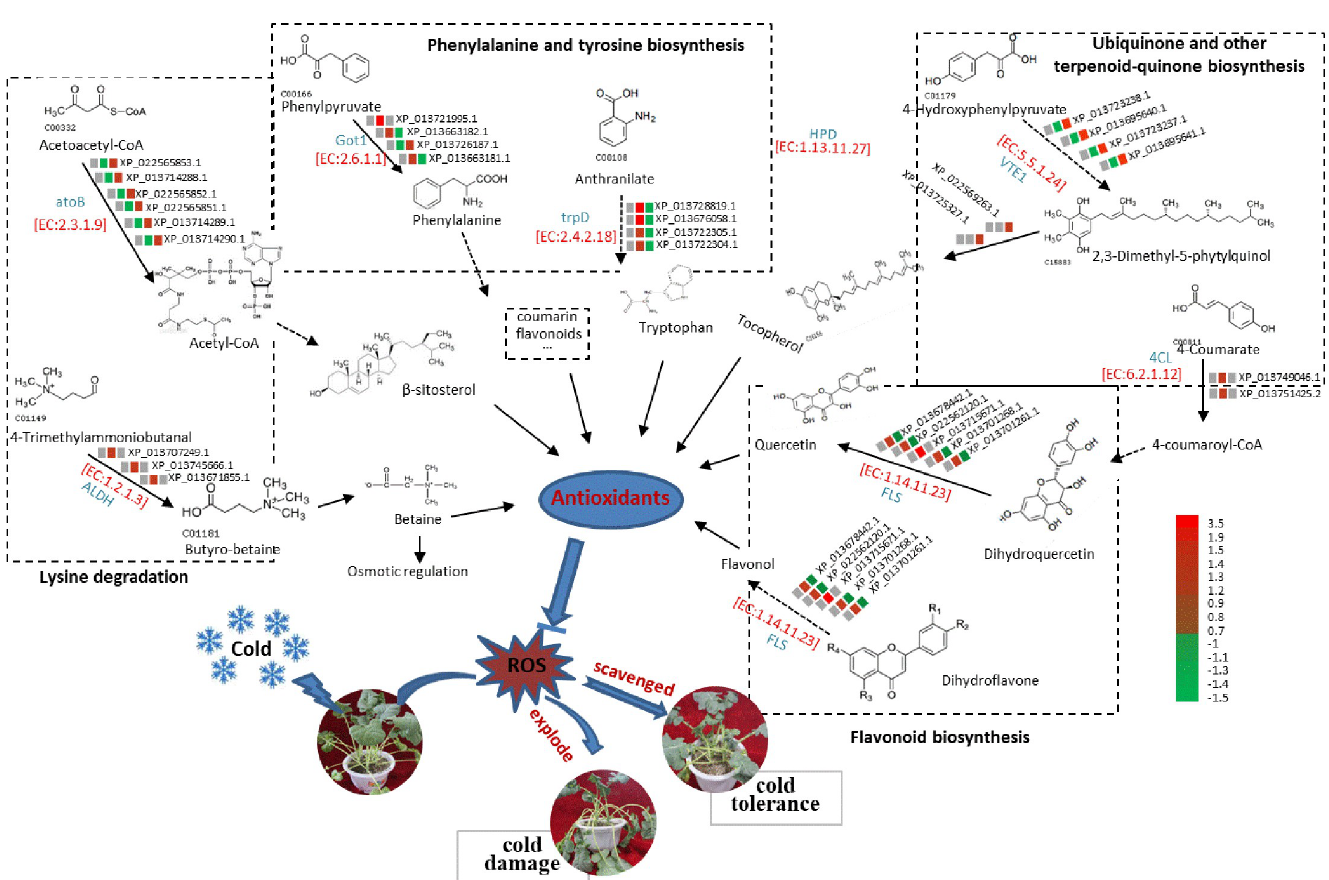
Fig 7. Differentially abundant proteins (DAPs) related to ROS scavenged under cold stress of winter rapeseed. Numbers and abbreviations of key enzymes are shown in red and blue text, respectively. Three small squares on a line represented three cold treatments, and color change from green to red meaning DAP accumulative level change from high to low. Arrow with line indicated synthetic direction, line ending with a bar indicated suppressive producing.